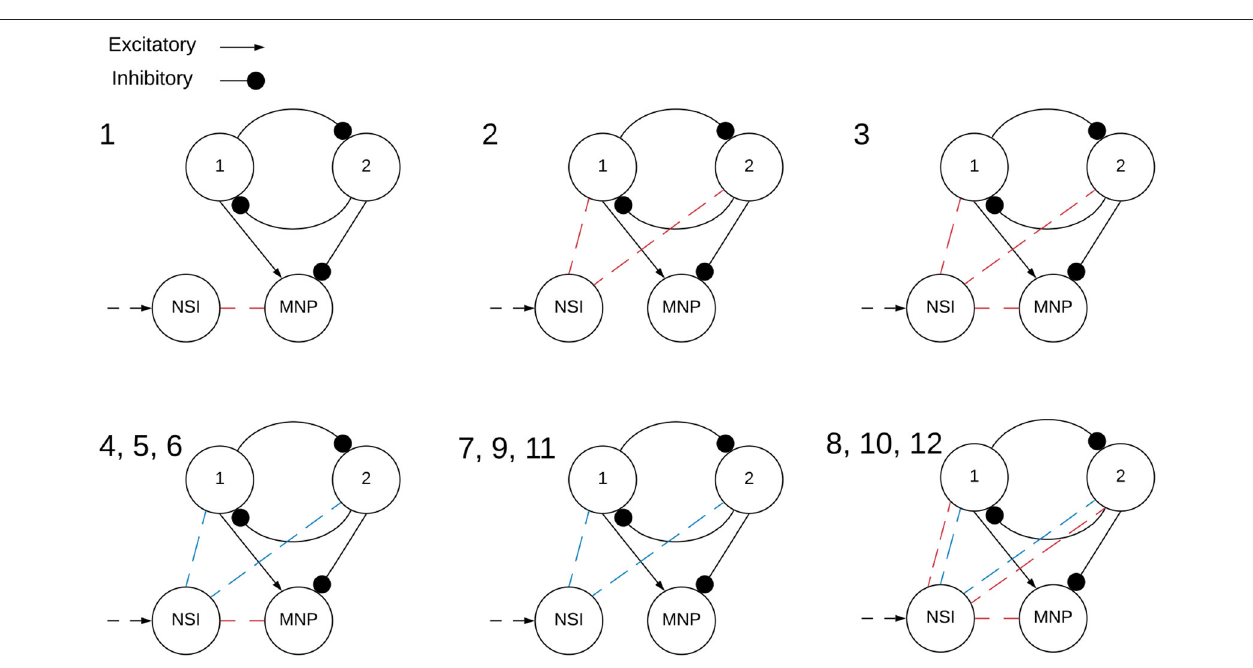
Frontiers in Neuroscience |